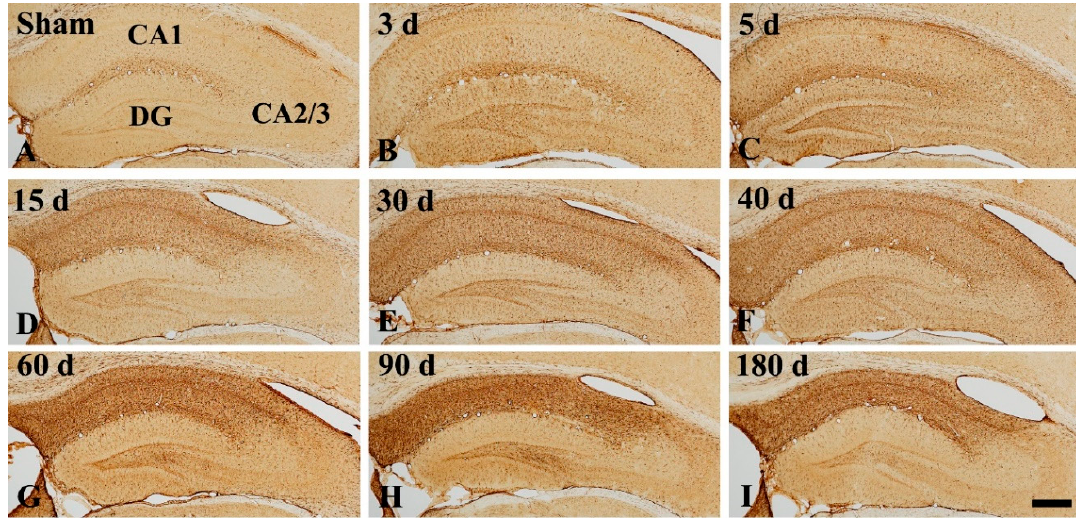
Figure 4. Low magnification of GFAP immunohistochemistry in the hippocampus of the sham operated ( A ) and ischemia operated ( B – I ) groups after tgCI. In the sham operated group, glial fibrillary acidic protein (GFAP) immunoreactivity is shown lower part of the CA1. From 3 days after tgCI, GFAP immunoreactivity in the CA1 is increased and very strong in all layers from 15 days post-tgCI. The immunoreactivity in the CA1 is highest at 90 days after tgCI. In the CA2/3, GFAP immunoreactivity is slightly increased at 3 and 5 days after tgCI. Scale bar = 400 µ